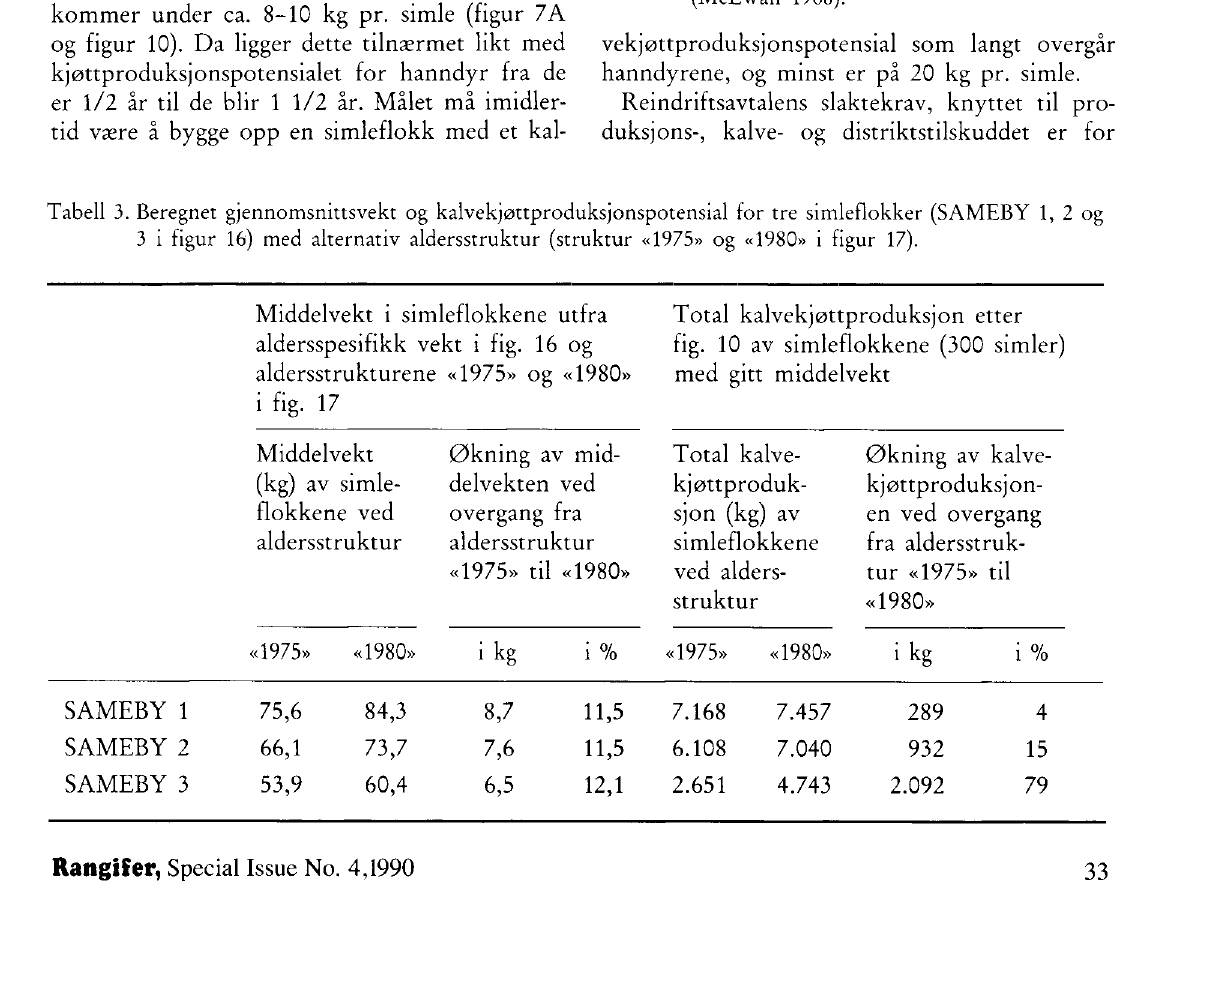
Figur 18. Kjøttproduksjon (fettlagring ikke medreg net) på bukker i forhold til alder og ernæ ring. «Foret» er uten restriktiv ernæring, mens «Beiting» er med restriktiv ernæring (McEwan 1968).